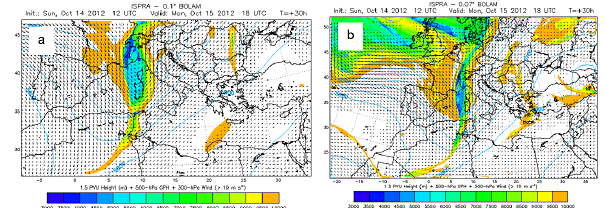
Figure 16. 500hPa GPH (blue contour lines), 300hPa wind ( > 10ms − 1 ) and 1.5PVU isosurface (color shaded area) for the forecast initialized at 12:00UTC of 14 October 2012 and valid at 18:00UTC of 15 October 2012 for (a) : 0.1 ◦ BOLAM-ISPRA and (b) 0.07 ◦ BOLAM-ISPRA.